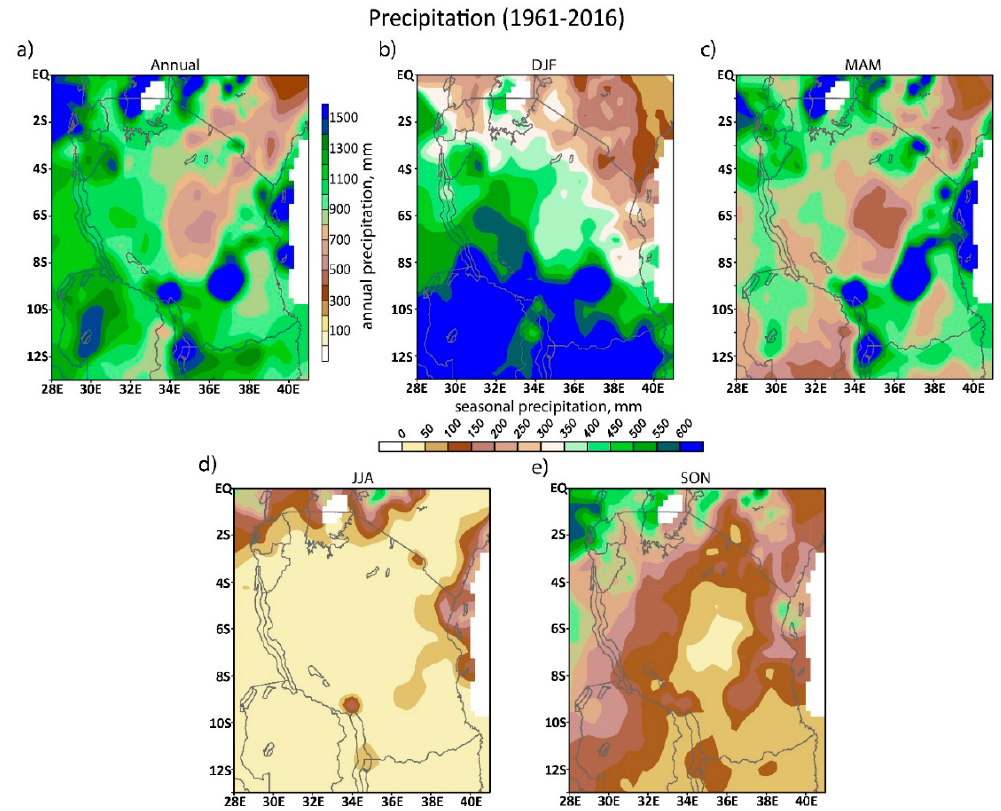
Figure 2. Annual and seasonal precipitation climatology calculated from 1961–2016 Global Precipitation Climatology Centre (GPCC) precipitation data. ( a ) Annual precipitation, ( b ) Dec–Feb summer precipitation, ( c ) Mar–May fall precipitation, ( d ) Jun–Aug winter precipitation, and ( e ) Sep–Nov spring precipitation. Precipitation is in mm.